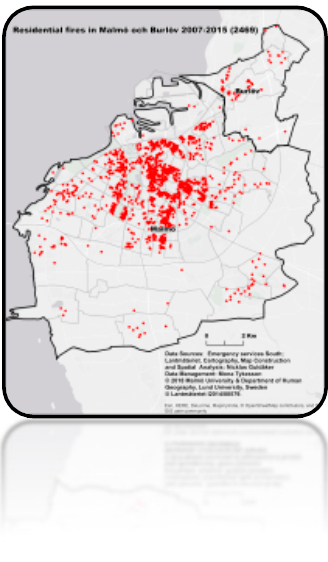
Figure 7. Point Figure 7. Point map.